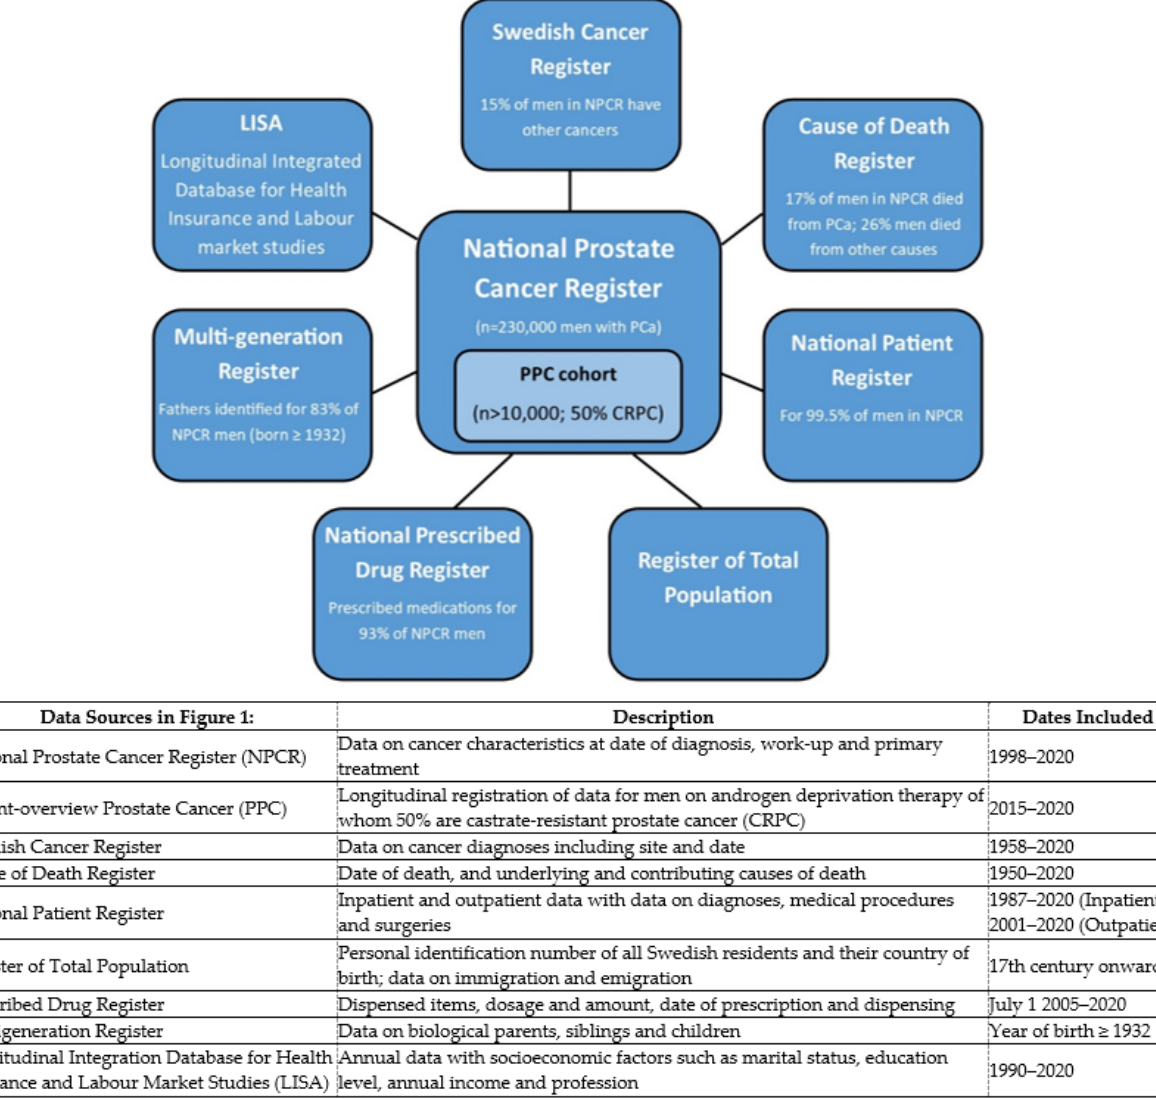
Figure 1. National healthcare and demographic registers to be included in Prostate Cancer data Base Sweden (PCBaSe) 5.0 in 2021.